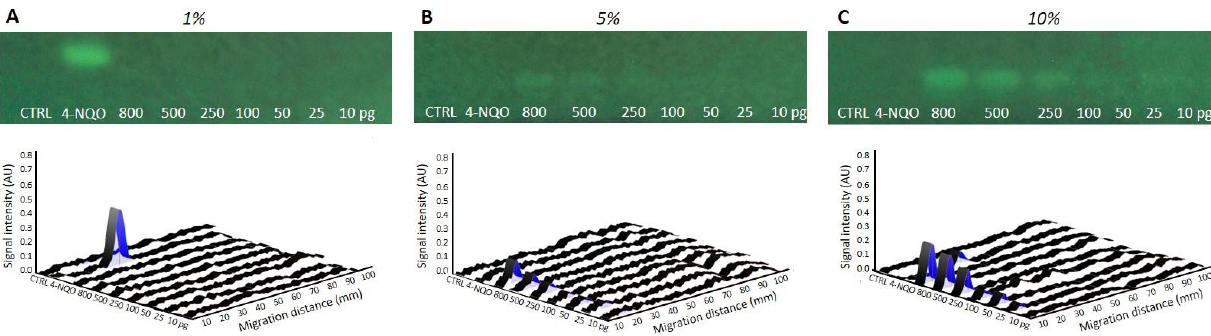
Figure 1. Bioautogram at FLD 254 nm showing the region of interest for optimization of the metabolic activation varying percentage (%) of mixtures of the S9 fraction, with co-factors, at ( A ) 1%, ( B ) 5%, and ( C ) 10%. Biodensitograms at 485/>500 nm of AFB1 (10−800 pg/band), along with the positive control 4-NQO (500 pg/band) and methanol solvent control (CTRL, 10 µL/band). pg/band (0.08 pmol).